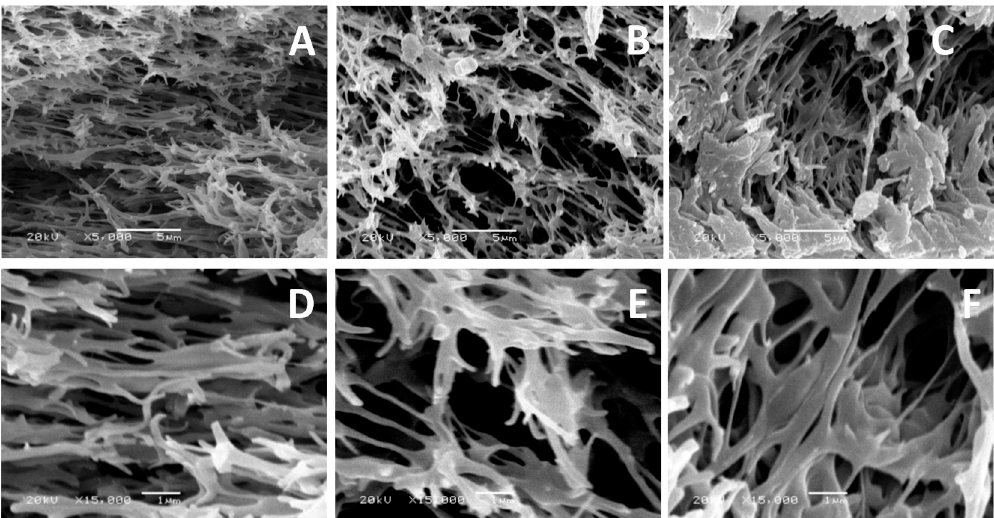
Figure 9. The scanning electron microscope (SEM) images for the cross-section of the blank poly(ethersulfone) (PES) membrane, ( A ) 5000× and ( D ) 15,000×; the modified PES membrane using 5 mM 2-AP and at 25 °C reaction temperature, ( B ) 5000× and ( E ) 15,000×; and modified PES membrane using 15 mM 2-AP and at 40 °C, ( C ) 5000× and ( F ) 15,000×. Common reaction condition is pH 5.5 (0.1 M sodium acetate buffer), 0.5 U·mL − 1 enzyme (laccase), and 60 min reaction (modification) time.